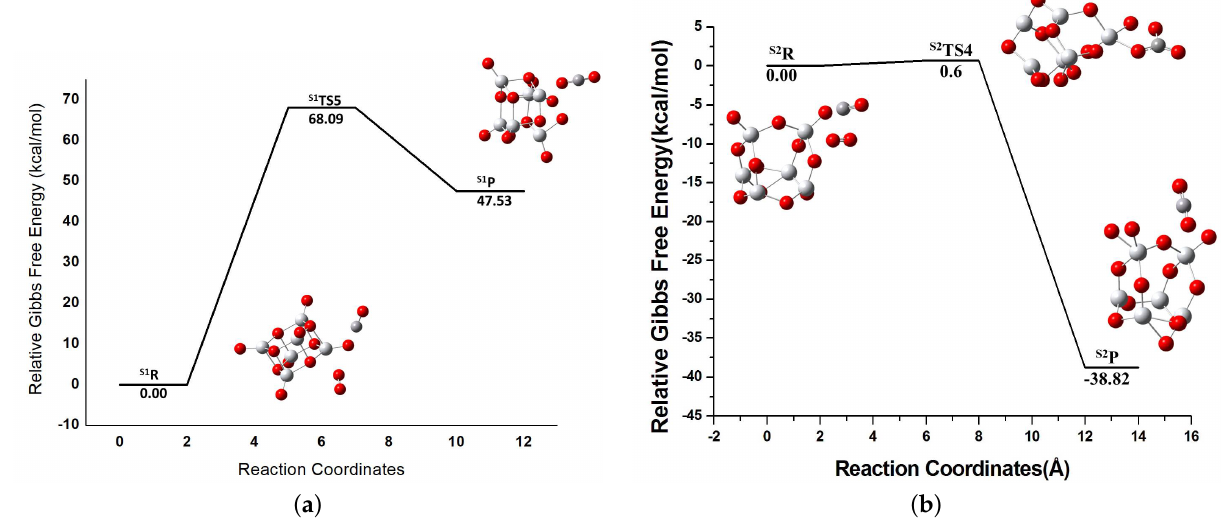
Figure 9. Energy profile for the LH mechanism for ( a ) the S1 isomer and ( b ) the S2 isomer. In the upper part, S 1 R, S 1 TS5, and S 1 P represents reactant, transition state 5, and product for the reaction with the S1 isomer as catalyst. In the lower part, S 2 R, S 2 TS4, and S 2 P represents reactant, transition state 4, and product for the reaction with the S2 isomer as